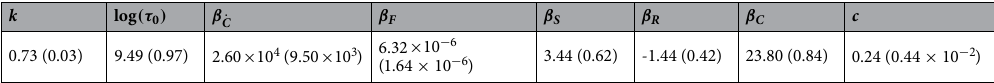
Table 1. Gamma IAFT-model parameter estimates and corresponding standard errors for the Groningen case.